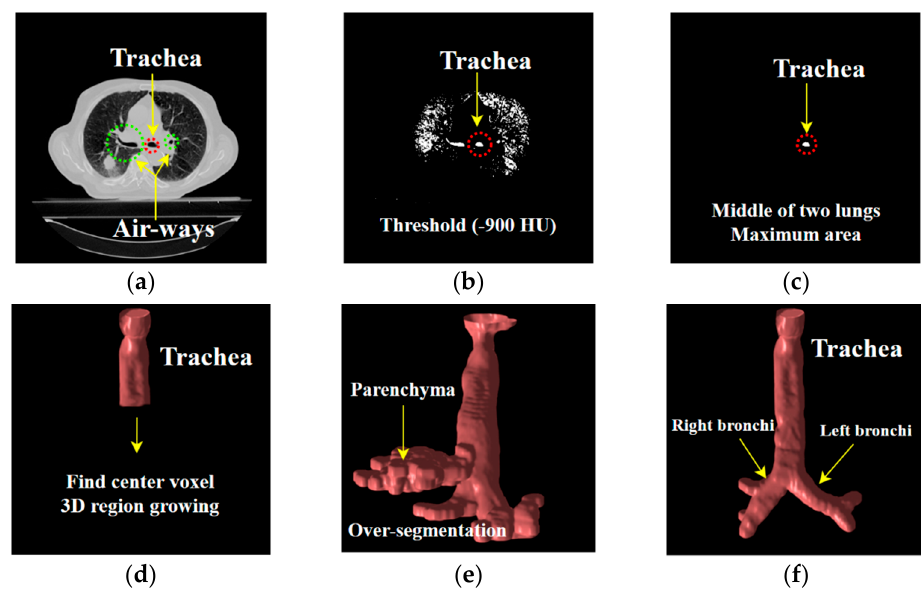
Figure 5. Segmentation of the trachea and bronchial airway: ( a ) input 2D CT slice, ( b ) segments of air-filled regions, ( c ) a segment of the trachea, ( d ) isotropic structure of segmented trachea, ( e ) leakage of region growing into the parenchyma, ( f ) isotropic structure of successfully segmented trachea and bronchial tree.